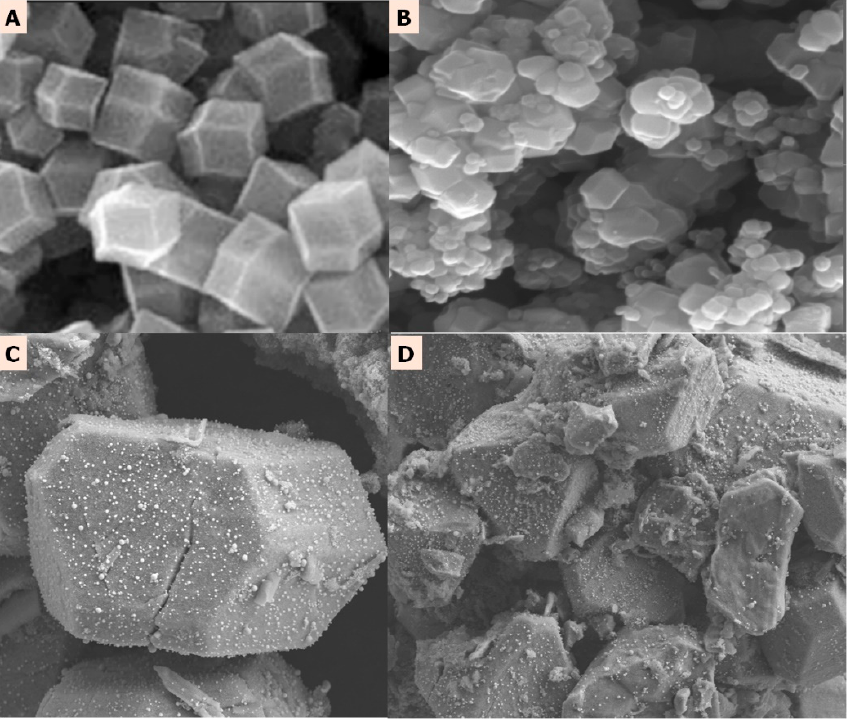
Figure 12. SEM images of ( A ) ZIF-8 surface. ( B ) Gly@ZIF-8 surface, ( C ) ZIF-8-PCL surface, and ( D ) Gly@ZIF-8-PCL surface.